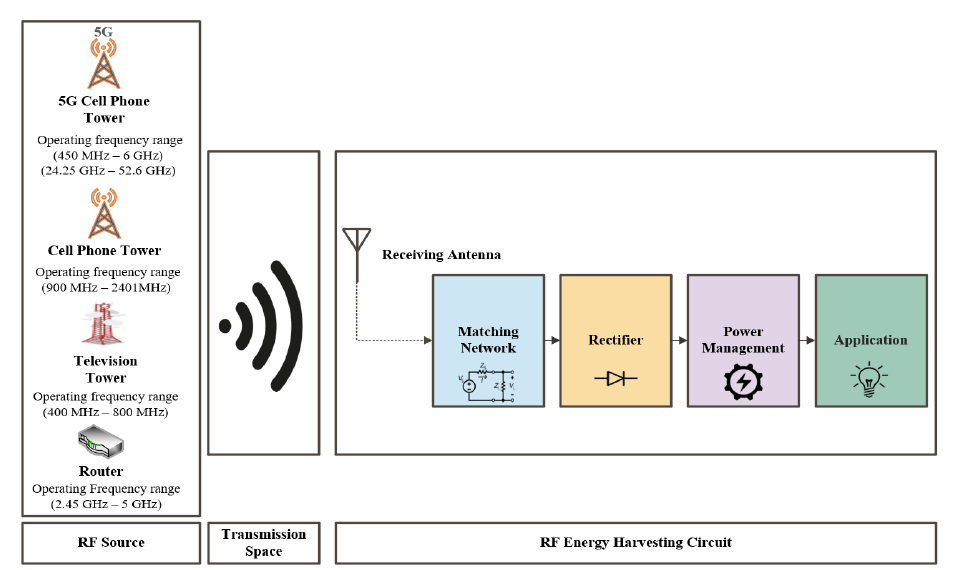
Figure 2. Schematic illustration of the RF energy harvesting system.